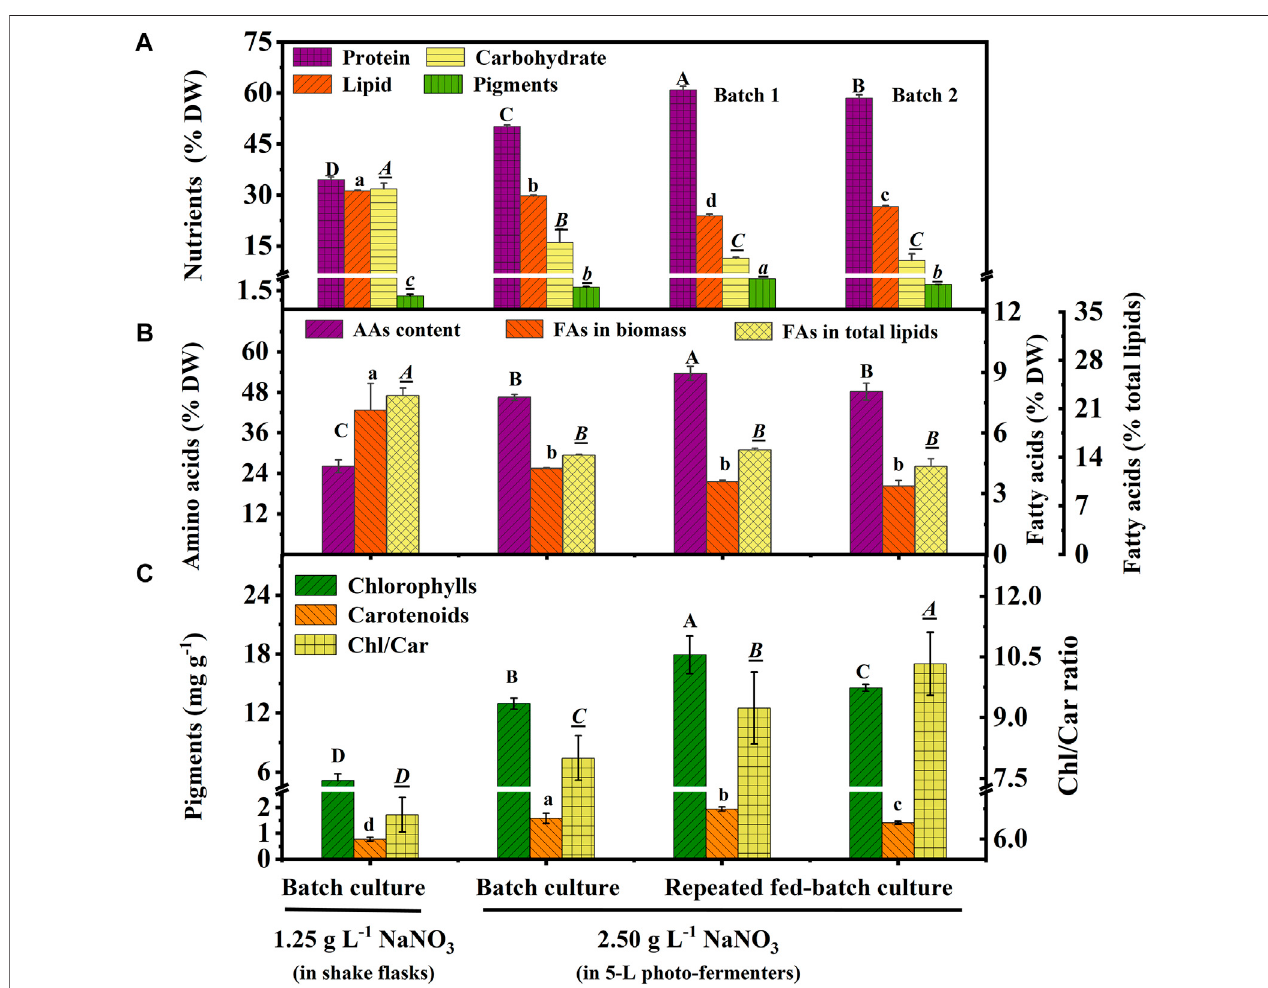
FIGURE 3 | Nutrients (A) , amino acids and fatty acids (B) , and pigment contents with the ratio (C) in biomass of autotrophic C. subellipsoidea in the batch and repeated fed-batch cultures under various nitrate concentrations in shake fl asks and 5-L photo-fermenters. The different letters on the bar represent the signi fi cant difference ( p < 0.05) between the